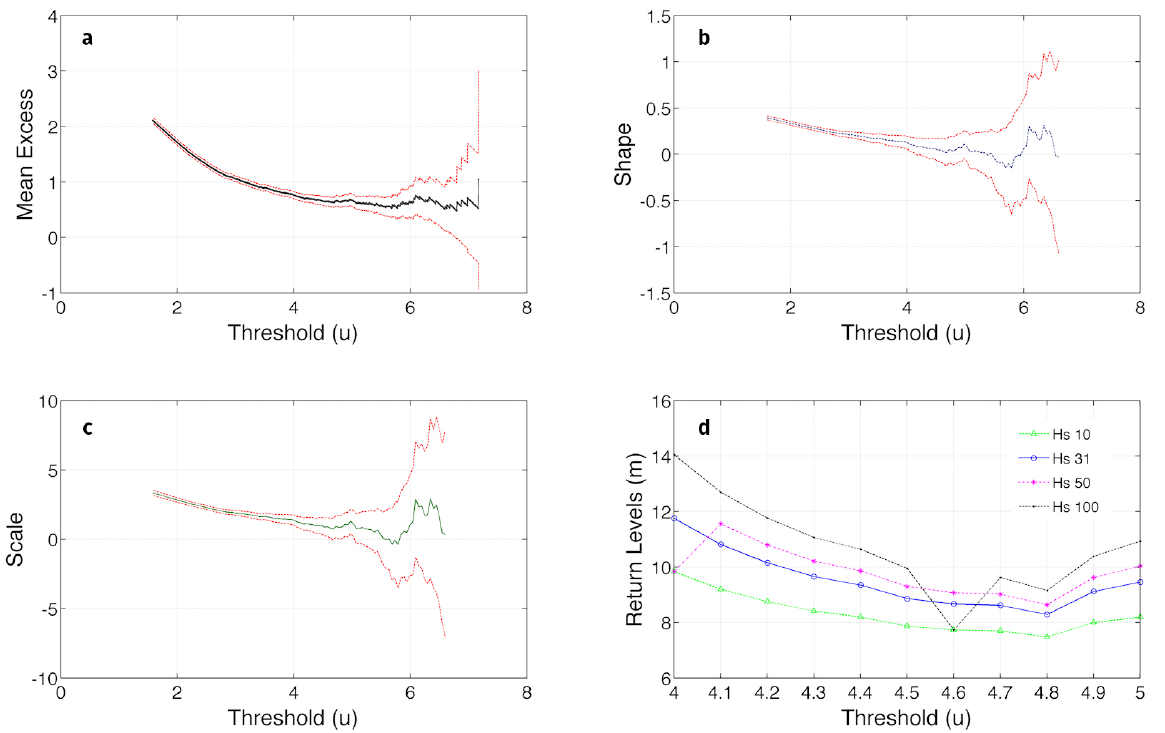
Figure 7. (a) MRL- mean residual life over u versus u. (b) Shape parameter with 95% confidential interval (red dashed line) for ML estimator versus u. (c) Scale parameter with 95% confidential interval (red dashed line) for ML estimator versus u. (d) Return values/levels (100, 50, 31 and 10 years) versus